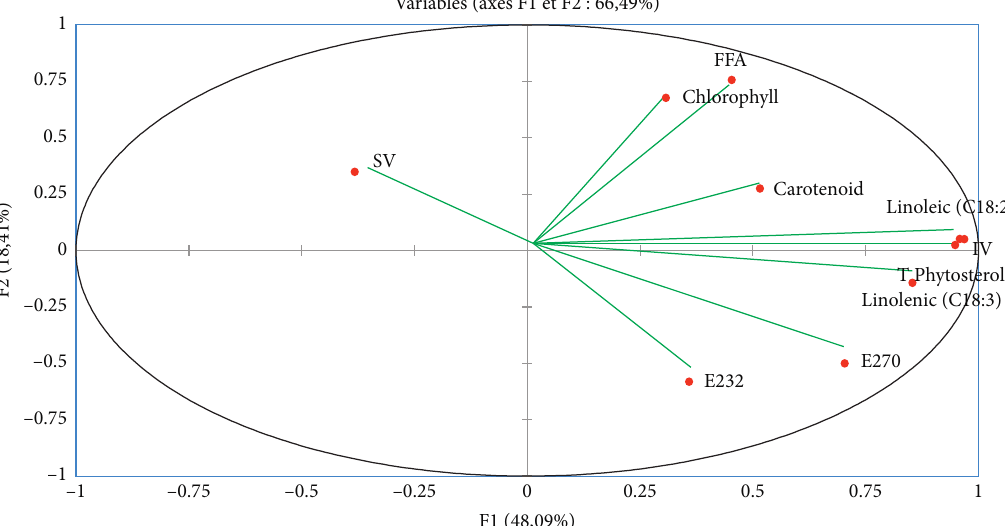
Figure 4: PCA factorial plan carried out on the values (FFA, IV, SV, E232, E270, chlorophyll, carotenoid, total phytosterols, and PUFAs (Linolenic (C18:3) and Linoleic (C18:2)) of the different samples of POOs.